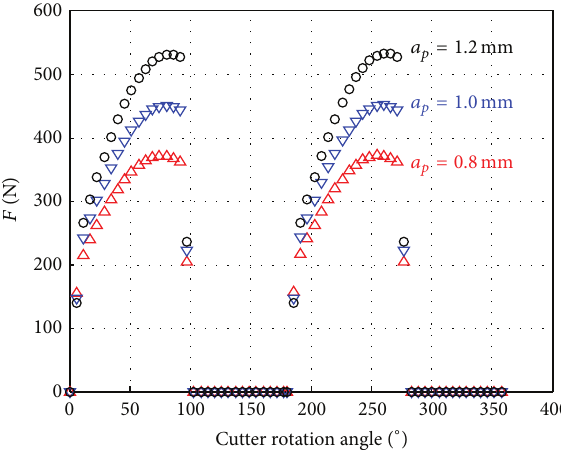
Figure 13: Effect of cutting depth on cutting